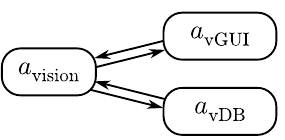
Figure 9. Structure of the vision module.